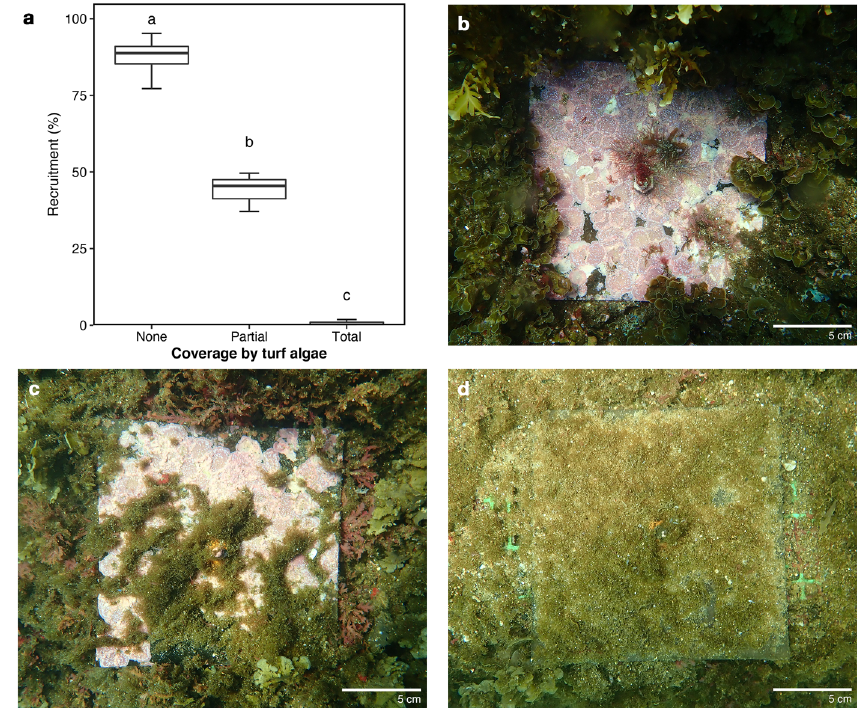
Fig. 7 In fl uence of turf algae on the recruitment of other algae. a Boxplots showing the effects of the presence of turf algae on the recruitment of crustose coralline algae. The presence of the turf algae was classi fi ed as no coverage ‘ None ’ (see b , n = 4 biologically independent tiles), partial coverage ‘ Partial ’ (see c , n = 3 biologically independent tiles) or total-coverage ‘ Total ’ (see d , n = 4 biologically independent tiles). For the boxplots, the line inside indicates the median, the upper and lower hinges correspond to the interquartile range, and the upper and lower whiskers extend to the highest and lowest values that are within 1.5 × the interquartile range of the hinge. A signi fi cant difference between the coverage groups is indicated with a different letter (ANOVA with Tukey ’ s HSD post-hoc